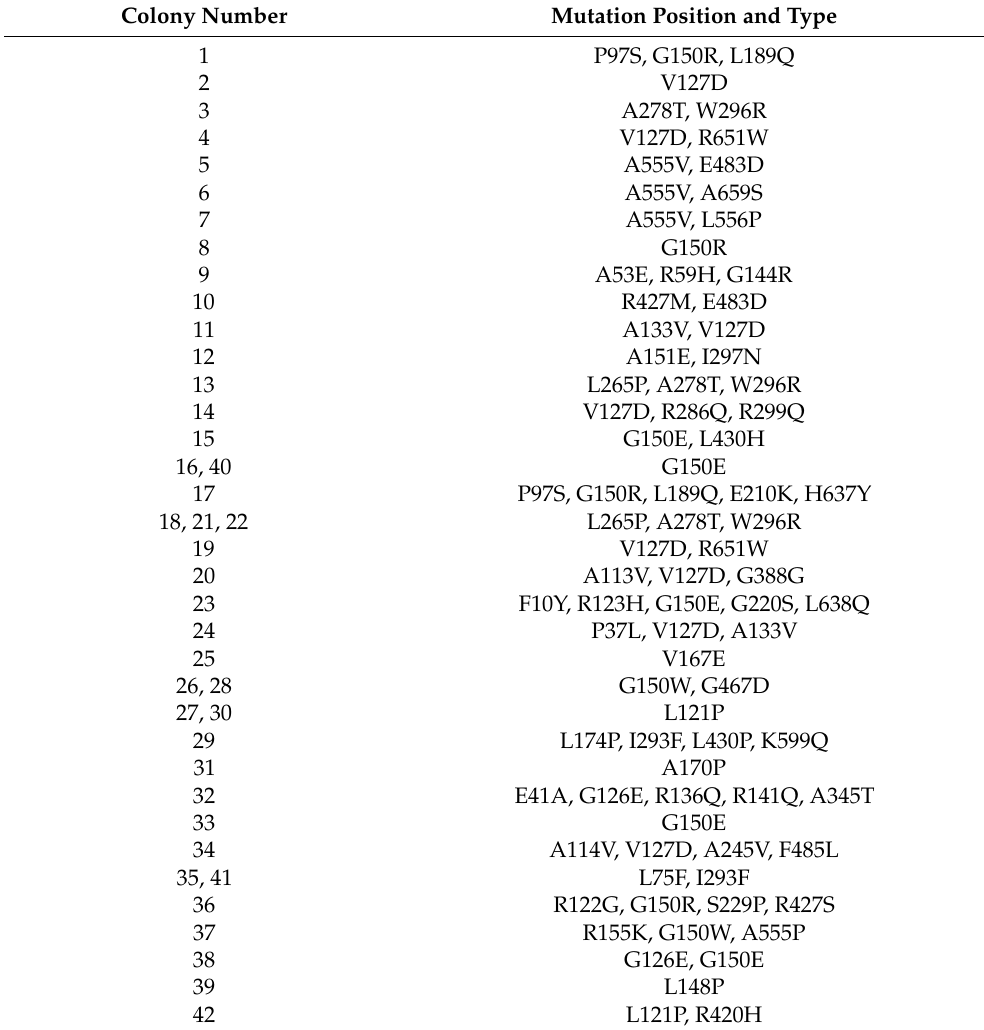
Table 3. Sequencing result of screened mutant of TtAgo. Colony Number Mutation Position and